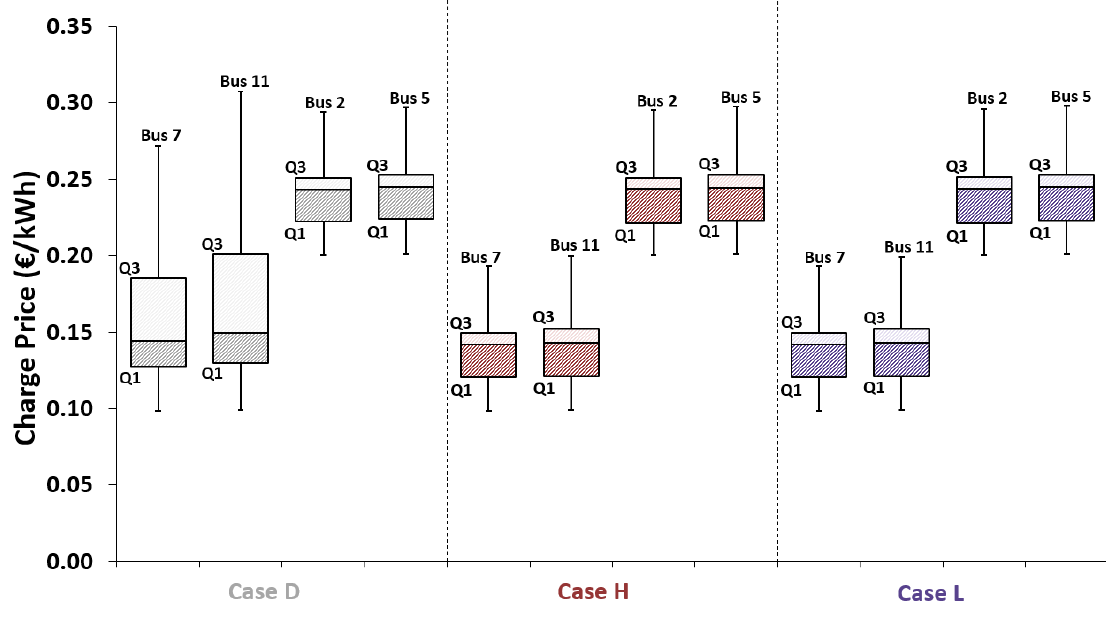
Figure 16. Electric vehicle charging price variation in the user distance preference